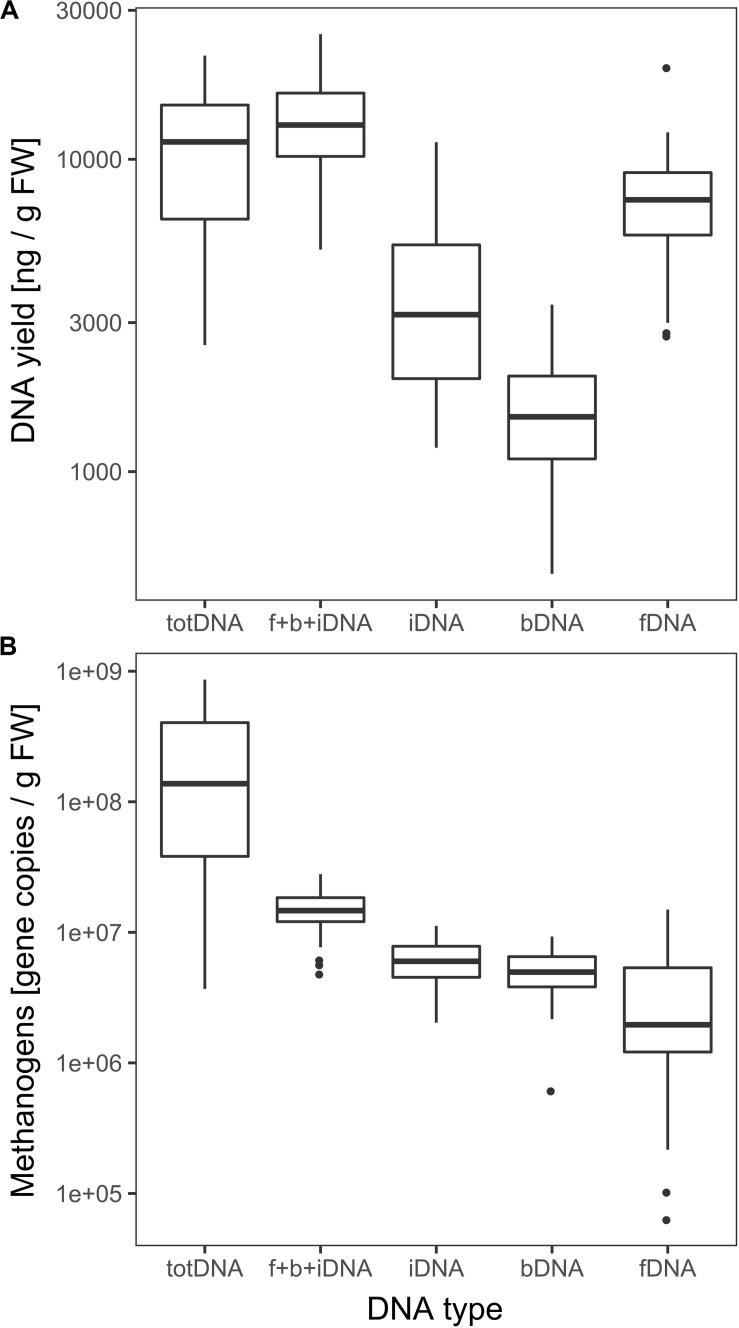
(A) Logarithmic overall DNA yields and (B) mcrA gene copies of the various DNA pools. Vertical lines represent the median, boxes the quartiles and dots the outliers of all data collected over time.